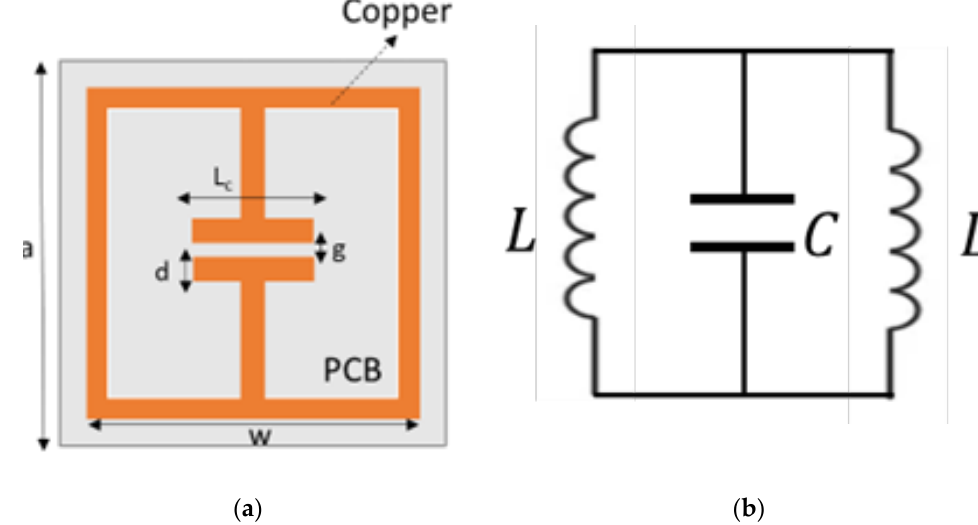
Figure 2. ( a ) ELC unit cell of proposed GRIN Metasurface lens ( b ) Equivalent circuit of ELC resonator unit cell.